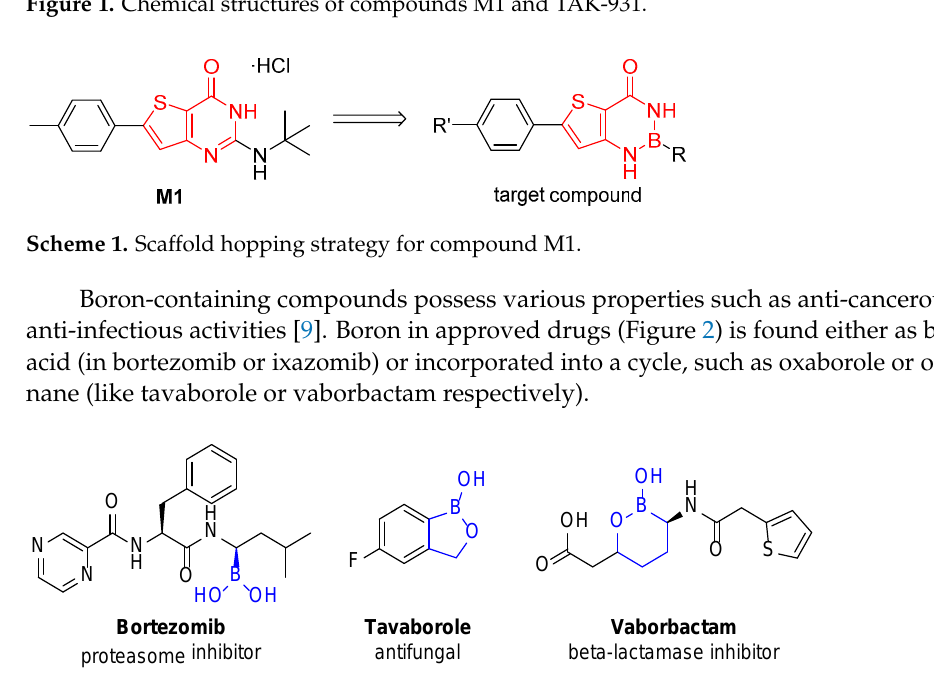
Figure 1. Chemical structures of compounds M1 and TAK-931.